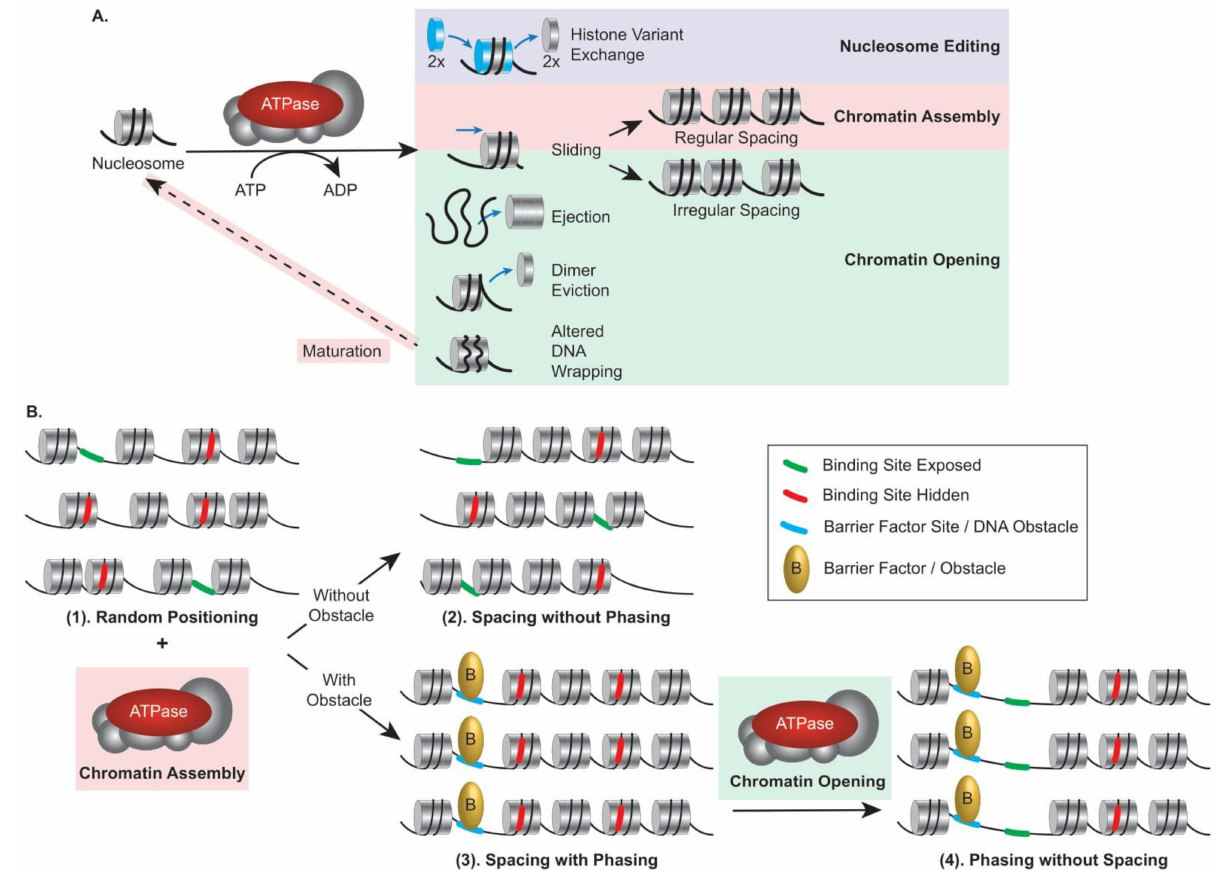
Figure 1. Chromatin processes, nucleosome spacing and phasing, and remodelers’ contribution. ( A ) Contribution of remodelers to various chromatin processes. Using their ATPase subunit, remodelers can contribute to (i) chromatin opening (light green background) by ejecting nucleosomes, irregularly spacing nucleosomes through sliding, evicting dimers, or altering DNA wrapping; (ii) chromatin assembly (light pink background) by maturating deposition or regularly spacing nucleosome; and (iii) nucleosome editing (light purple background) by modifying octamer composition through installation or removal of histone variants (blue partial cylinder). ( B ) Contribution of remodelers to nucleosome spacing and phasing. (1) Within a genome population, the deposition of histone octamers results in random nucleosome positioning with a mix of blockage (red) and exposure (green) of specific cognate sites for DNA-binding proteins. (2) Upon remodeling by an assembly remodeler, without an obstacle, nucleosomes are regularly distributed along the DNA, resulting in regular spacing, but without phasing, as access to particular cognate sites remains heterogeneous across the population. (3) Alternatively, upon remodeling by an assembly remodeler, in the presence of an obstacle, e.g., a DNA sequence or a bound barrier factor, nucleosomes are regularly distributed along the DNA, resulting in regular spacing and phasing with homogeneous access to particular cognate sites across the population. (4) From a population of regularly spaced and phased nucleosome arrays, upon remodeling by an opening remodeler, nucleosomes can remain phased but lack regular spacing, leading to a homogeneity in the exposure of binding sites across the genome